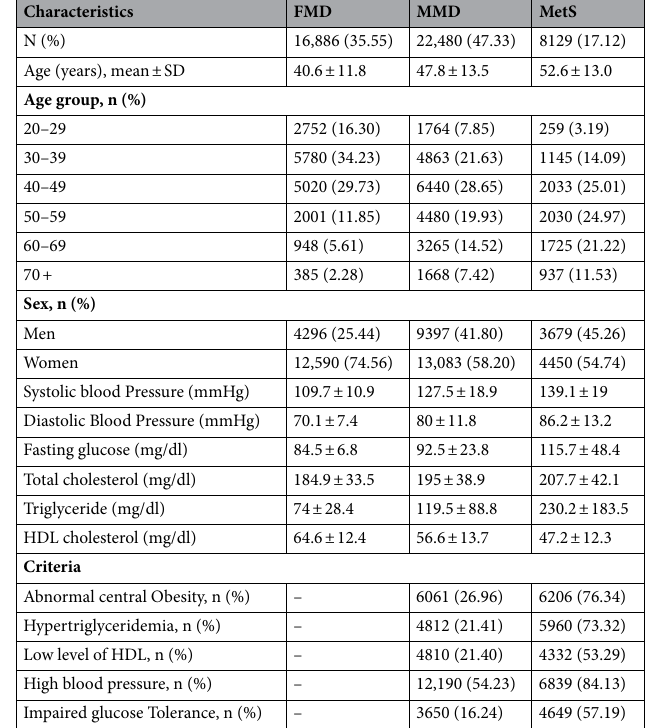
Table 1. The selected baseline characteristics of the study participants by the status of MetS. FMD free of MetS, MMD mild metabolic disorder with 1–2